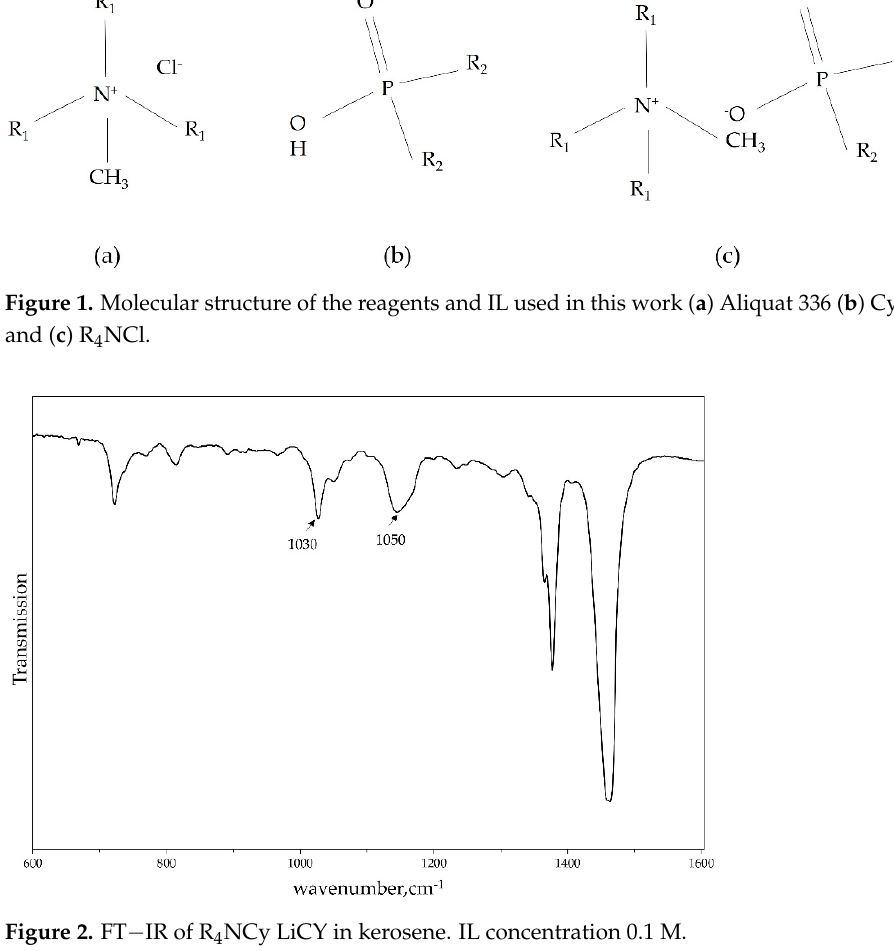
Figure 2. FT − IR of R 4 NCy LiCY in kerosene. IL concentration 0.1 M.